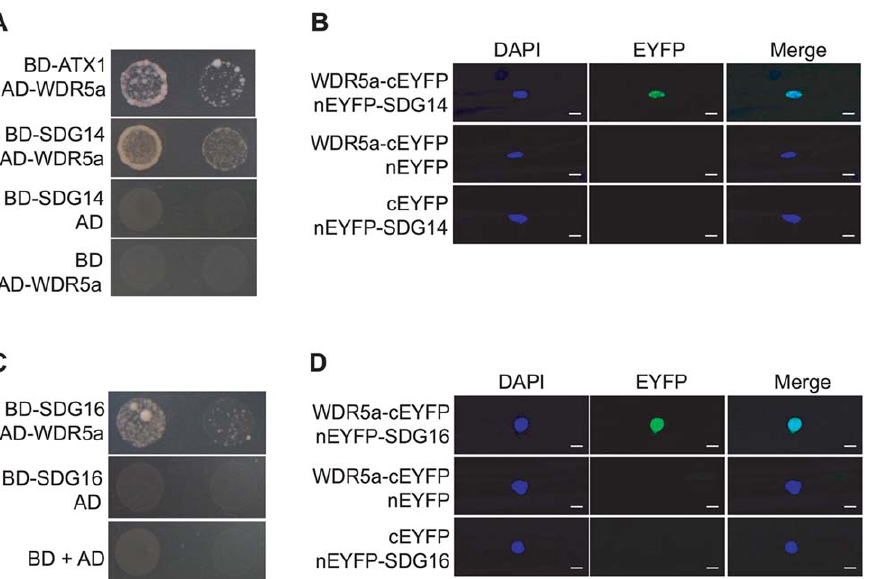
Figure 8. WDR5a Associates with Multiple Putative H3K4 Methyltransferases. (A) Interaction of WDR5a with SDG14 in yeast. Full-length WDR5a and SDG14 proteins were respectively fused with the GAL4 AD and BD domains. Yeast cells harboring these fusions, AD and/or BD, as indicated, were grown on the highly selective SD media lacking of Trp, Leu, His and adenine. (B) Physical interaction of WDR5a-cEYFP with nEYFP- SDG14 in onion epidermal cells as analyzed by BiFC. Yellowish-green signal indicates the binding of WDR5a-cEYFP with nEYFP-SDG14 in the nuclei. Blue DAPI staining indicates nuclei. Bar = 20 m m. (C)Association of WDR5a with SDG16 in yeast. Full-length WDR5a and SDG16 proteins were respectively fused with the GAL4 AD and BD domains. (D) Physical interaction of WDR5a-cEYFP with nEYFP-SDG16 in onion epidermal cells analyzed by BiFC. Yellowish-green signal indicates the binding of WDR5a-cEYFP with nEYFP-SDG16 in the nuclei. Bar = 20 m m. (Figure 10B), consistent with that ASH2R promotes the expression of MAF4 and MAF5 , but not MAF3 . Furthermore, ChIP assays show that levels of H3K4me3 in both MAF4 and MAF5 in their 5 9 transcribed regions were strongly reduced, whereas H3K4me2 levels remained unchanged in both genes in ASH2R RNAi seedlings relative to Col (Figure 10C, 10D). Thus, ASH2R directly mediates H3K4 trimethylation not only in FLC , but also in MAF4 and MAF5 .